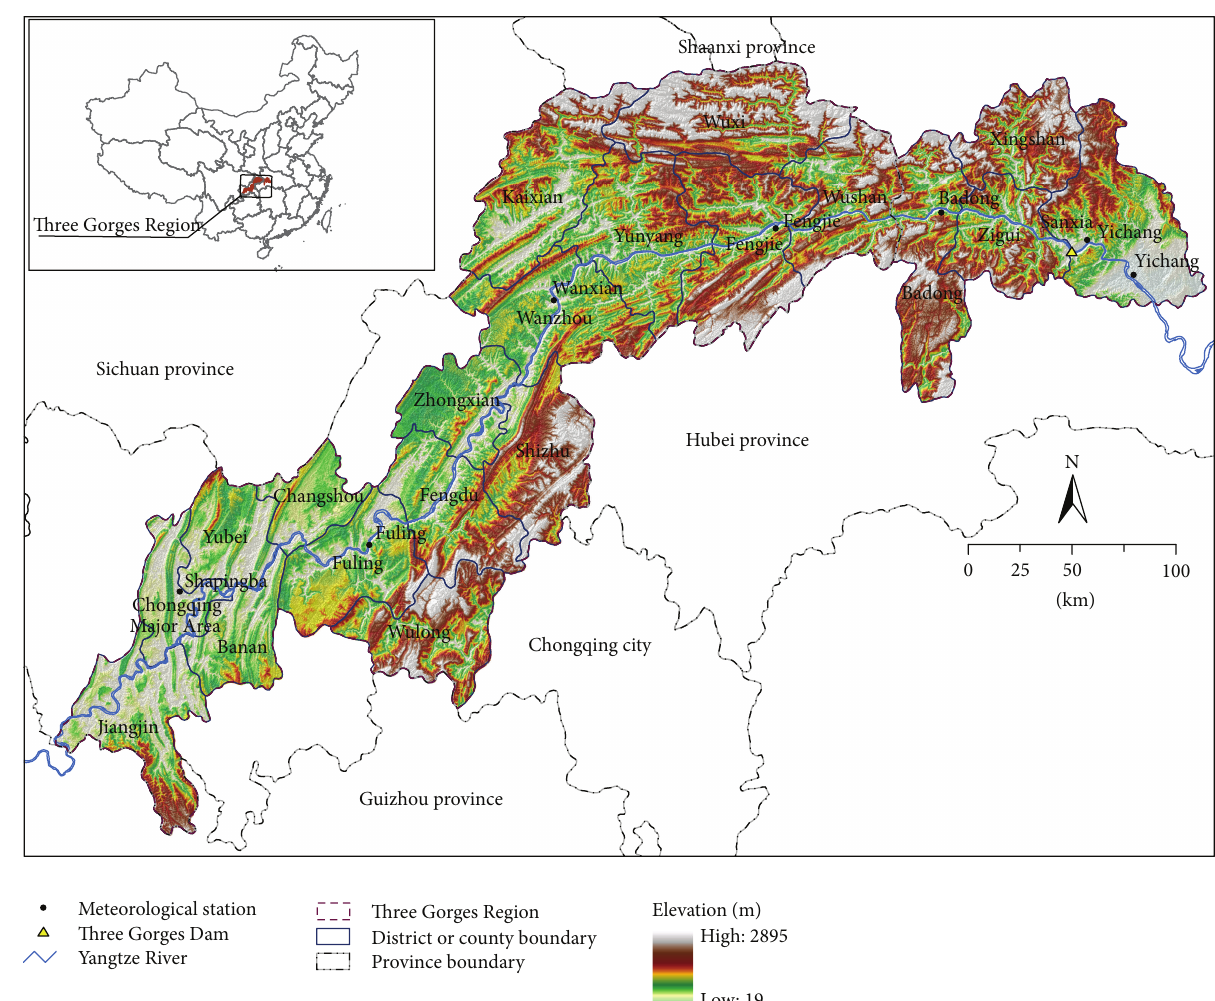
Figure 1: Location of the Three Gorges